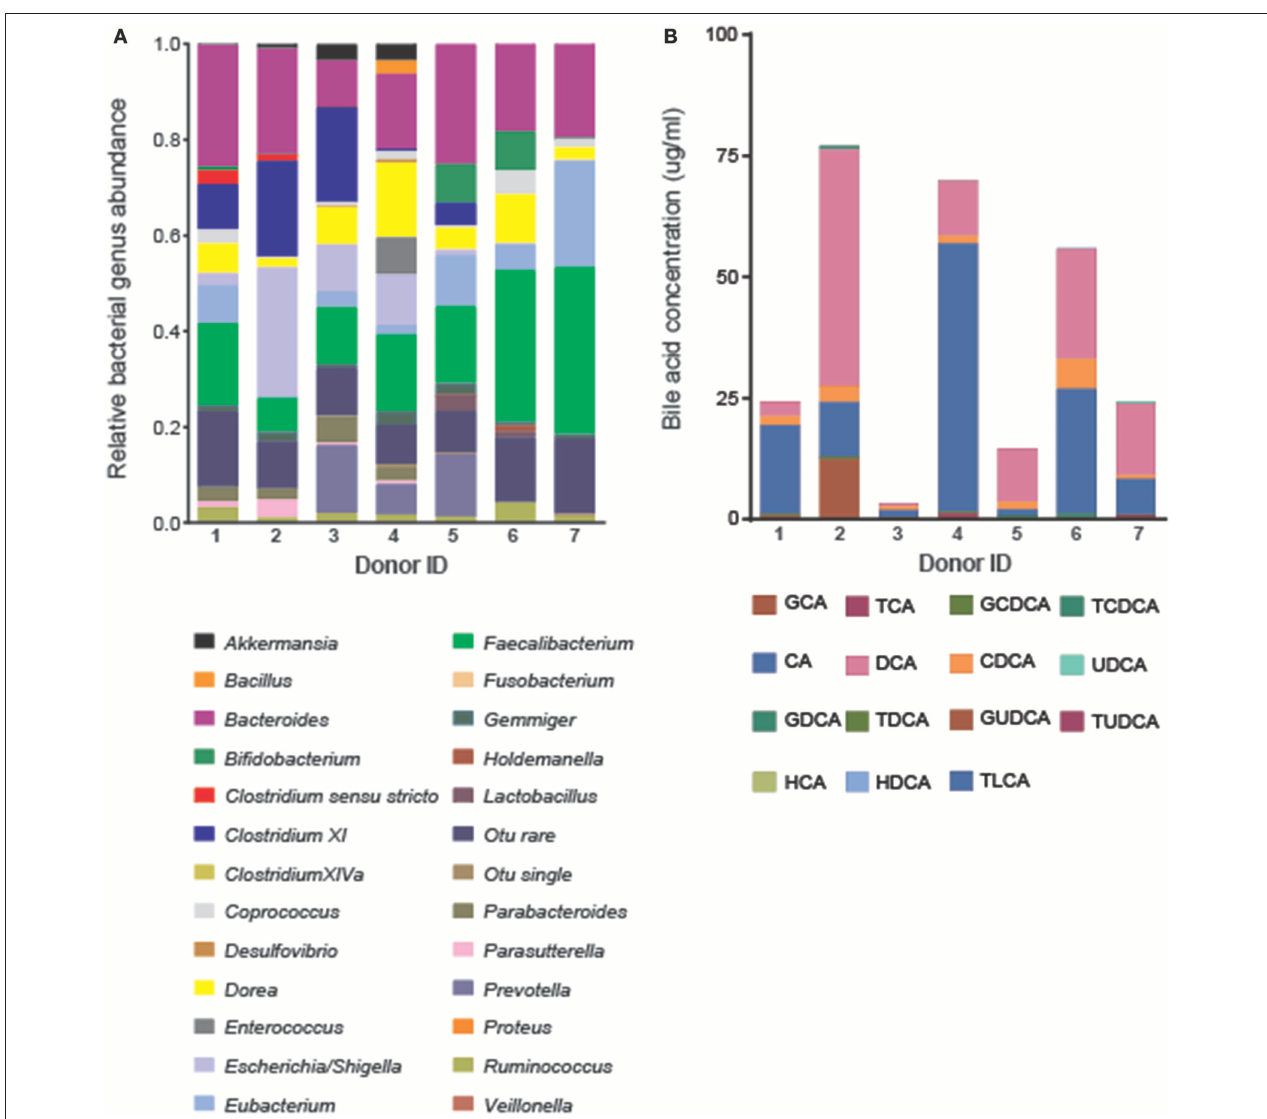
FIGURE 1 | Natural variation in fecal bile acid compositions and bacterial genera across healthy donors before treatment ( n = 7). (A) Fecal bacterial genus abundance was determined by Mothur analysis of the V1-V3 16S rRNA region of all fecal bacteria sequenced for each donor. (B) Fifteen bile acids moieties were quantified from the inoculated batch culture medium using